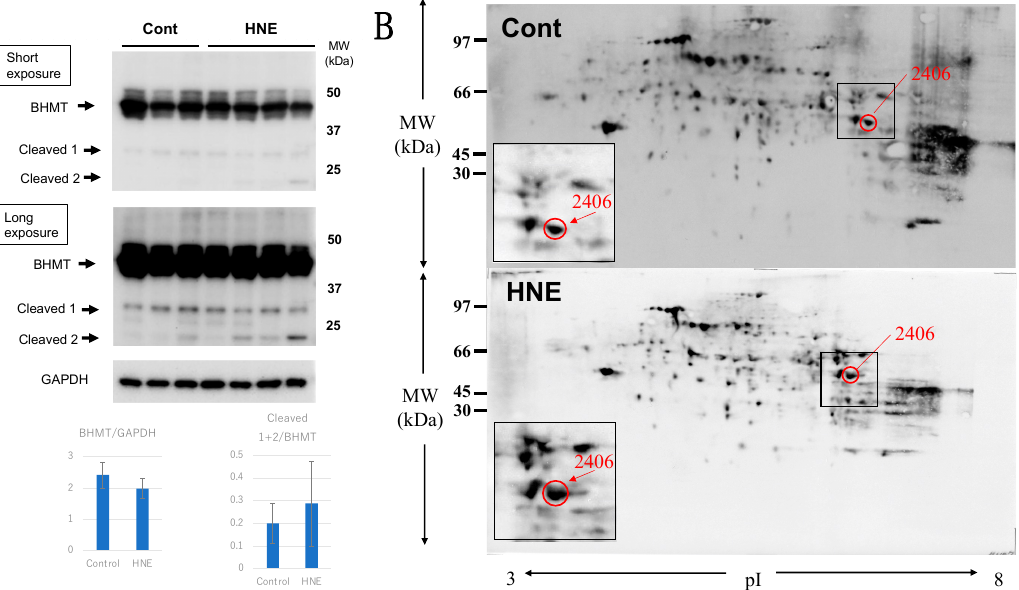
Figure 5. Western blotting ( A ) and 2D-Oxyblot analyses ( B ) of BHMT in the control and hydroxynonenal (HNE)-treated livers. Western blotting using the anti-BHMT antibody showed both a decrease in the BHMT naïve proteins (( A ), BHMT) and an approximate 1.5-fold increase in BHMT cleaved bands after both short and long exposures (( A ), cleaved 1 and 2), compared to the controls. As BHMT carbonylation was previously reported in the rodent model of alcoholic steatosis [36], here we focused on spots with similar MW and pI values in the 2D-Oxyblot analysis. Spot 2406 with a pI of 6.58 and MW of 44,998 (red circles) was identified as BHMT in the mass spectrometry analysis and via database matching. Compared to the controls (( B ), Cont), the degenerating liver after hydroxynonenal injections (( B ), HNE) showed a two-fold increase in the specific oxidation of BHMT (( A , B ) rectangles). In contrast, spots of carbonylated Hsp70.1 were not detected in the 2D-Oxyblot analysis (Figure 4C-b), which was in marked contrast to the ischemic brain [35] (Figure 4C-c). As the 2D electrophoresis gel is much larger than that of SDS-PAGE, the molecular marker only shows approximate positions.